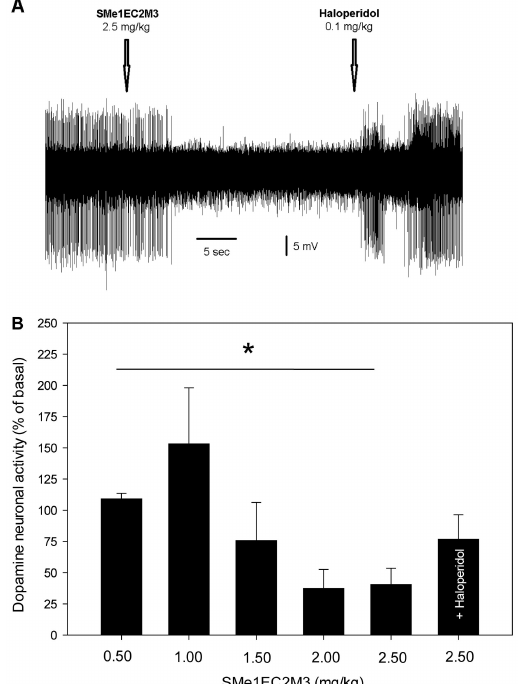
Figure 5. E ff ect of SMe1EC2M3 on the excitability of dopamine neurons of the ventral tegmental area. ( A ): representative recording from a single neuron; ( B ): summary result from seven neurons from seven rats, expressed as % ± SEM of basal activity. SMe1EC2M3 was applied at the cumulative doses of 0.5–2.5 mg / kg (i.v.). Two minutes after the last SMe1EC2M3 administration, a selective antagonist of D 2 receptors, haloperidol, was injected (0.1 mg / kg, i.v.); * p < 0.05, one-way ANOVA for repeated